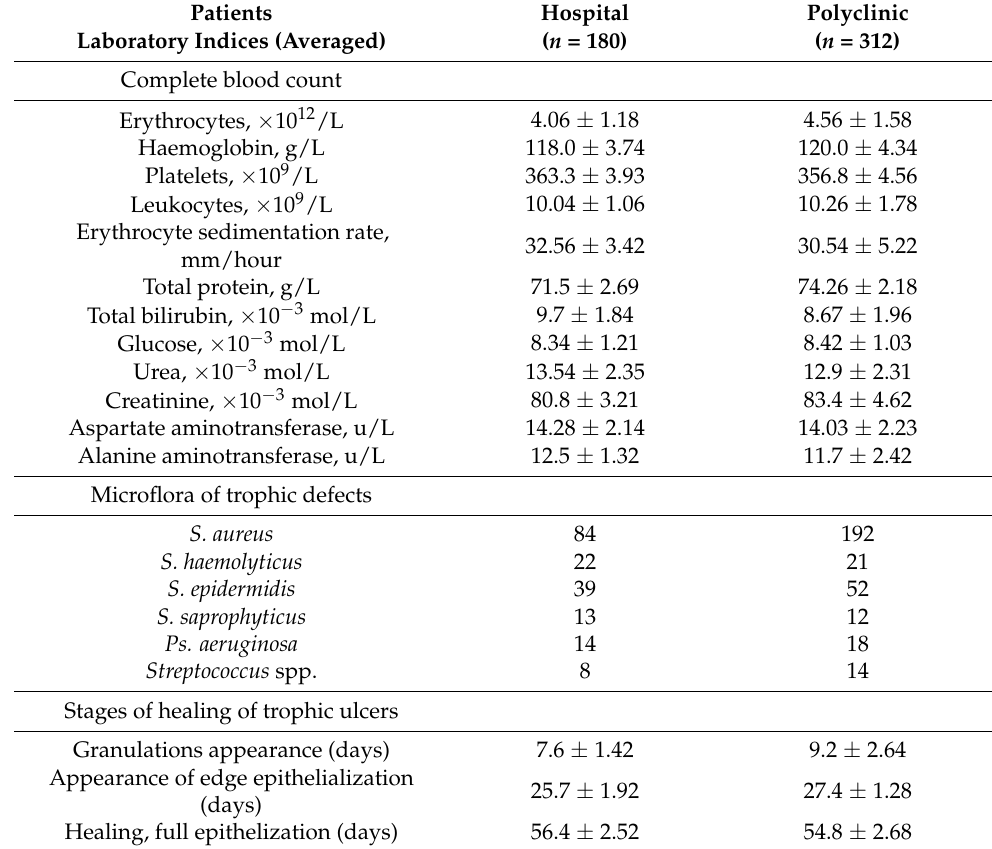
Table 5. Laboratory parameters and stages of trophic ulcer